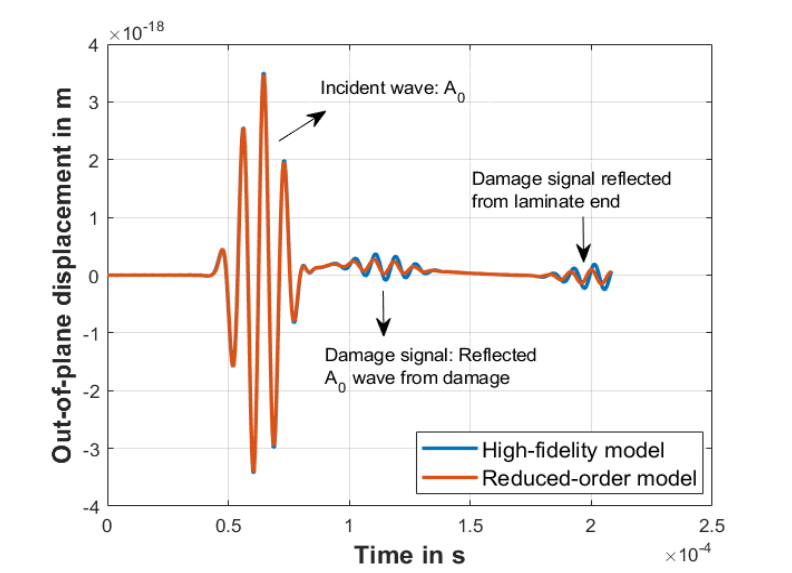
Figure 8. Reduced-order solution produced by the adaptive POD-greedy approach for the parameter outside the trained